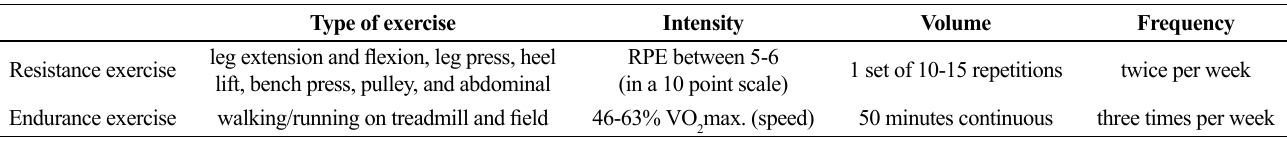
Table 2. Combined training program.